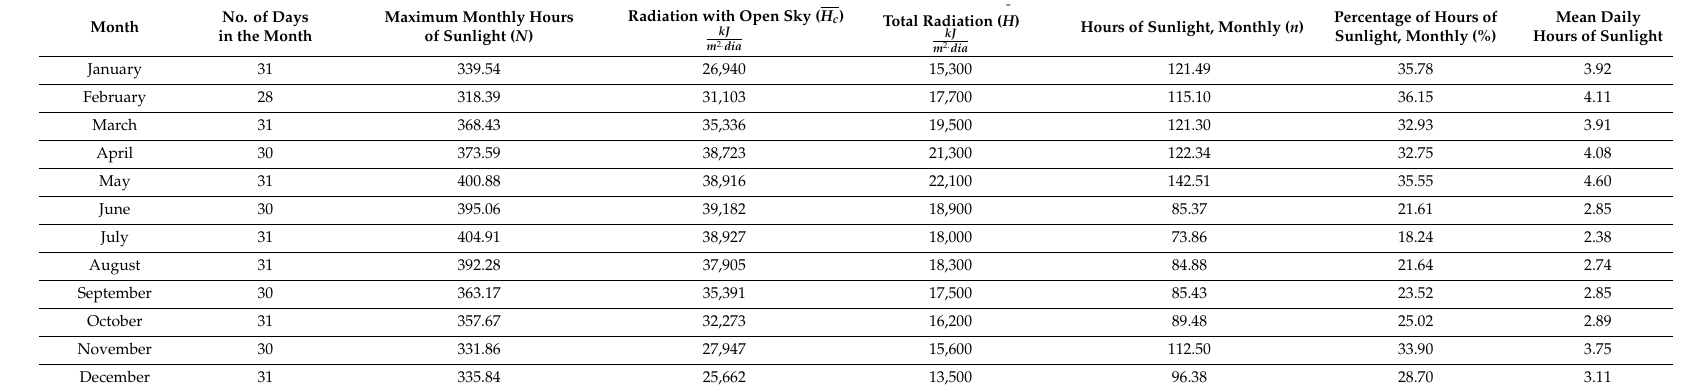
Table A1. Evaluation of monthly solar resources in the Cañada de los 11 Pueblos, Michoacan,